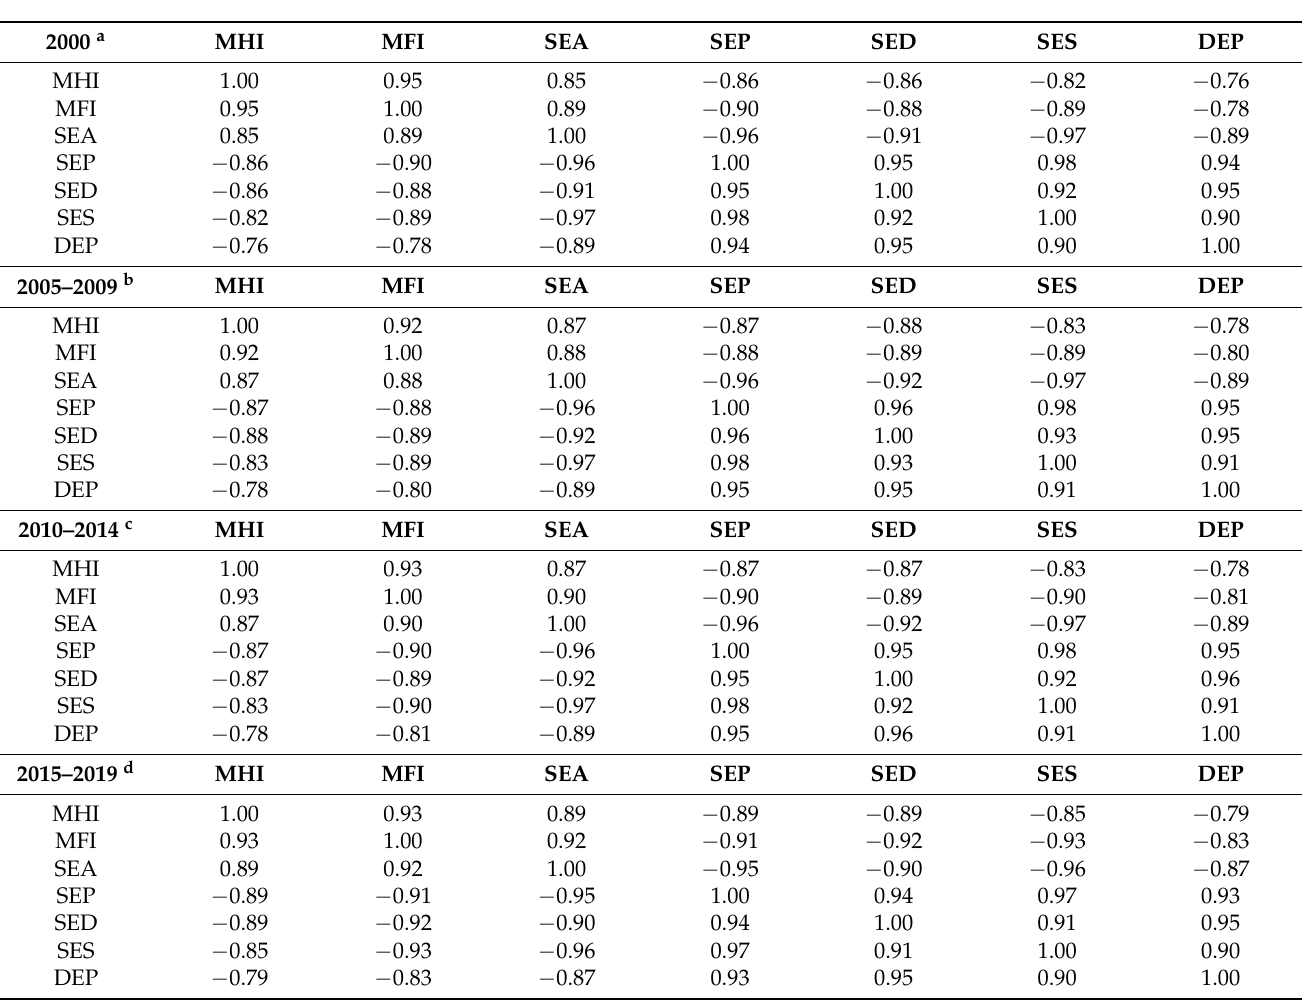
Table 5. Relationships between simple and composite measures of neighborhood socioeconomic status in the San Francisco–Oakland–Berkeley Metropolitan Statistical